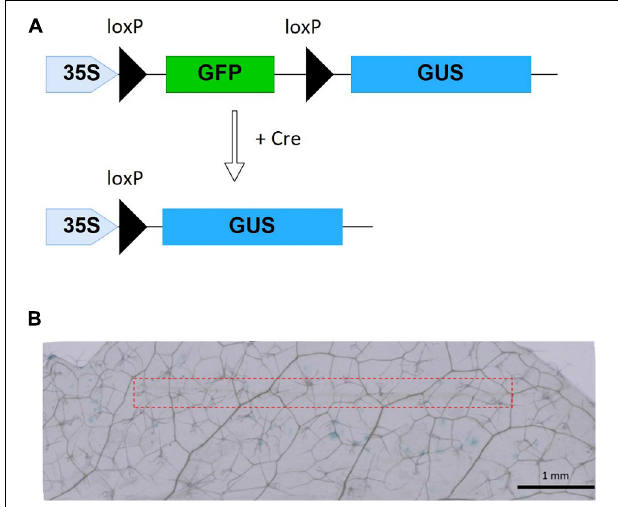
FIGURE 4 | Cre recombinase reporter system and Cre delivery results. (A) xGxGUS reporter system of A. thaliana. GFP, green fluorescent protein; GUS, β -glucuronidase; loxP , Cre recombinase target sequence. (B) GUS staining results after 40 h incubation with 10 µ M Cre insertion using MNA, the red dash line represents the area of MNA